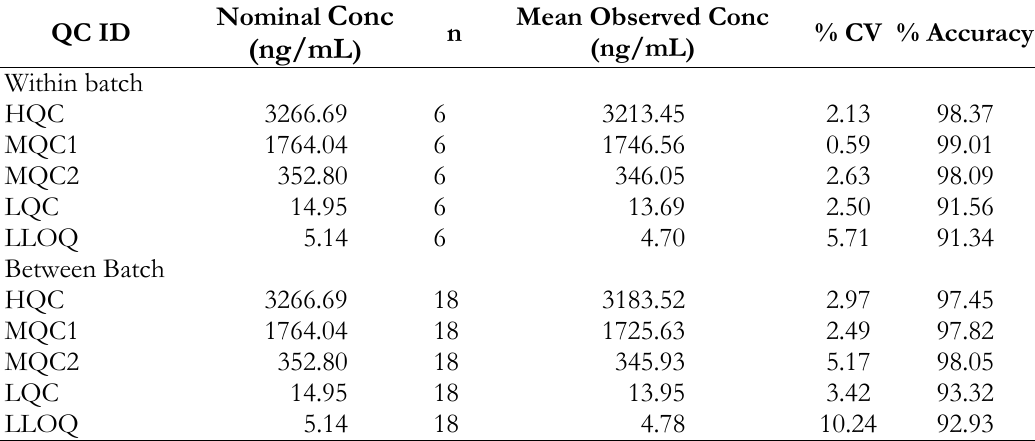
Table II. Within- and between batch Precision/Accuracy for omeprazole